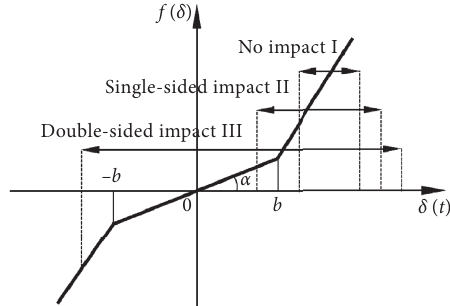
Figure 4: Piecewise linear function of gear backlash.